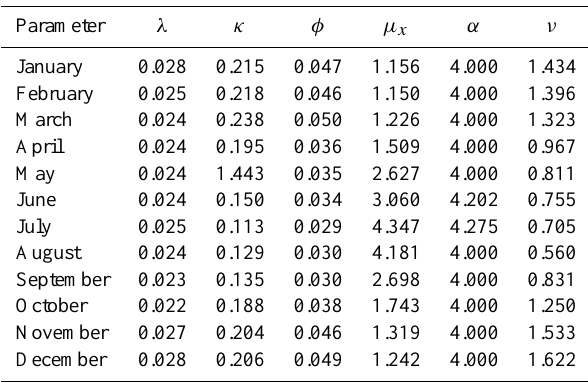
Table A2. Parameter set used for the MBL model.